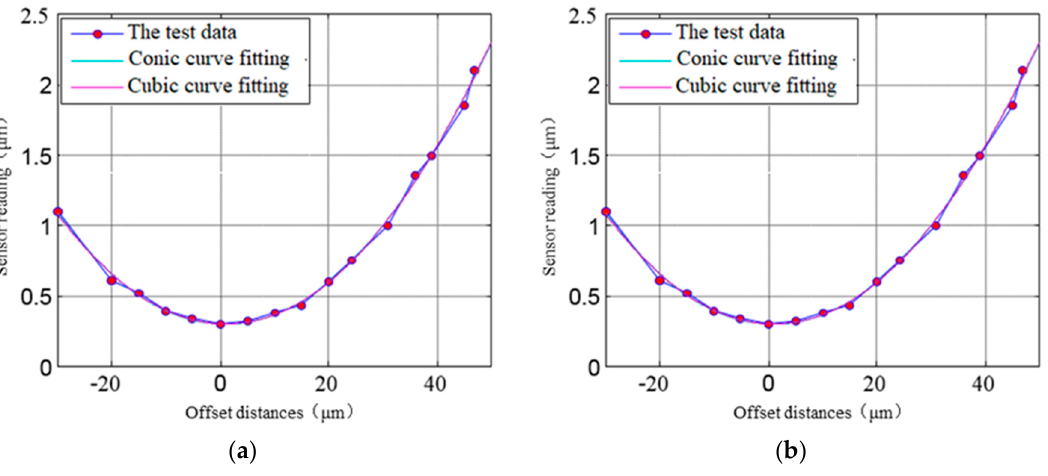
Figure 9. Nonlinear characteristics of lateral offset output of capacitive displacement sensor. ( a ) Sensor output when moving laterally at different offset distances, ( b ) Sensor output under different lateral initial offset.